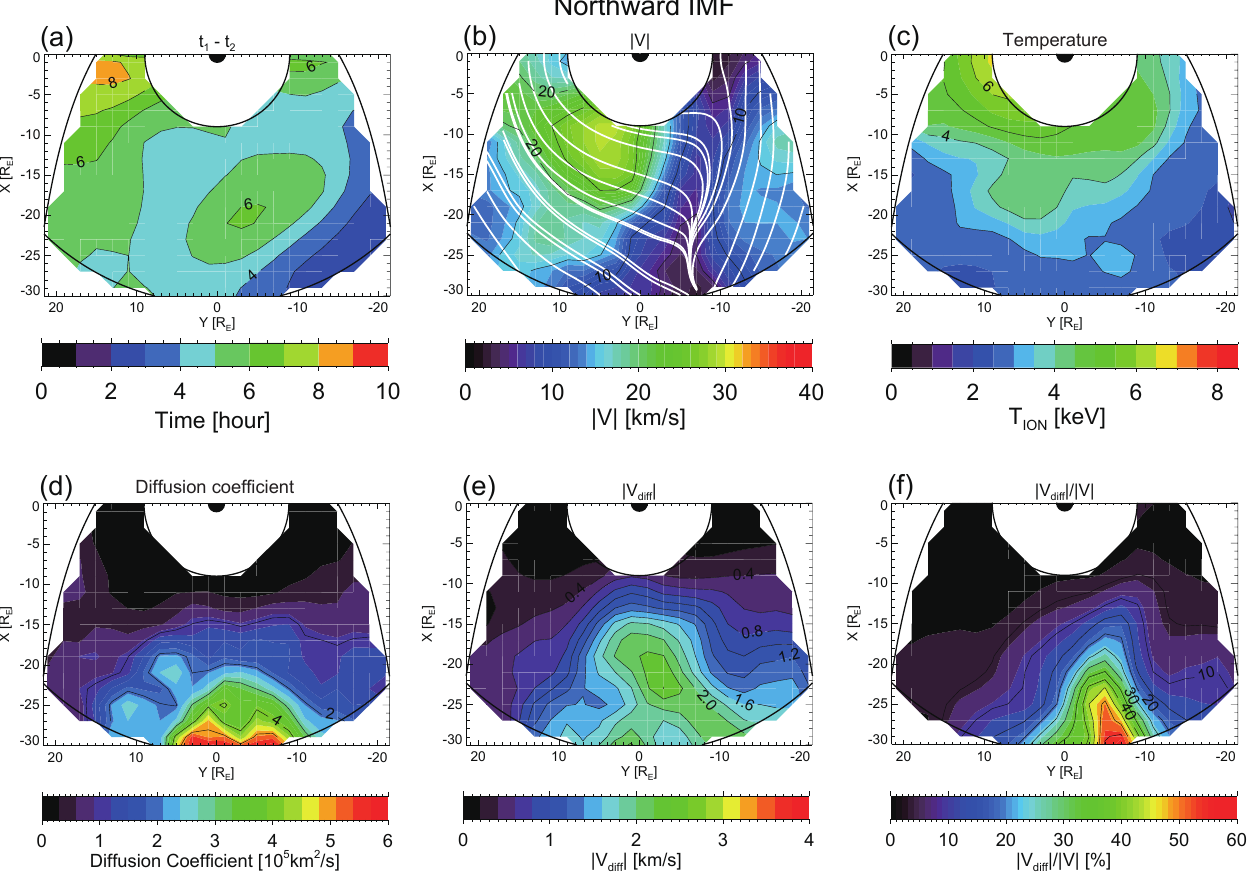
Fig. 16. (a) Equatorial distribution of IMF B z effect duration time for northward IMF. (b) Equatorial distribution of ion flow velocity. Stream lines are shown in white curves. (c) Distribution of average ion temperature. (d) Distribution of diffusion coefficient. (e) Distribution of diffusion speed. (f) Distribution of ration between diffusion speed and average ion bulk